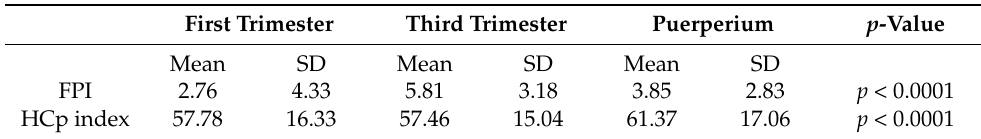
Table 1. Foot characteristics according to Foot Posture Index (FPI) and Hernández-Corvo protocol (HCp) index.